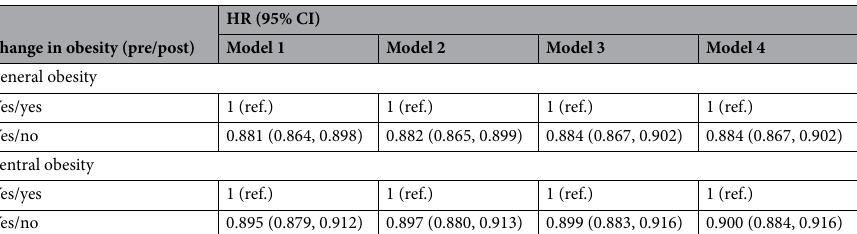
Table 6. Change in hazard ratio for the risk of knee OA due to the resolution of obesity in obese subjects. Model 1 was adjusted for age, sex. Model 2 was adjusted for age, sex, income, smoking, alcohol intake and regular exercises. Model 3 was adjusted for age, sex, income, smoking, alcohol intake, regular exercises, diabetes, hypertension and dyslipidemia. Model 4 was adjusted for age, sex, income, smoking, alcohol intake, regular exercises, diabetes, hypertension, dyslipidemia, cancer, end-stage renal disease, chronic obstructive pulmonary disease, stroke, liver cirrhosis, hear failure, dementia and chronic kidney disease. (Pre/post) means obesity status in the preceding and subsequent health examination. HR hazard ratio, CI confidence interval, OA osteoarthritis, IR incidence rate.